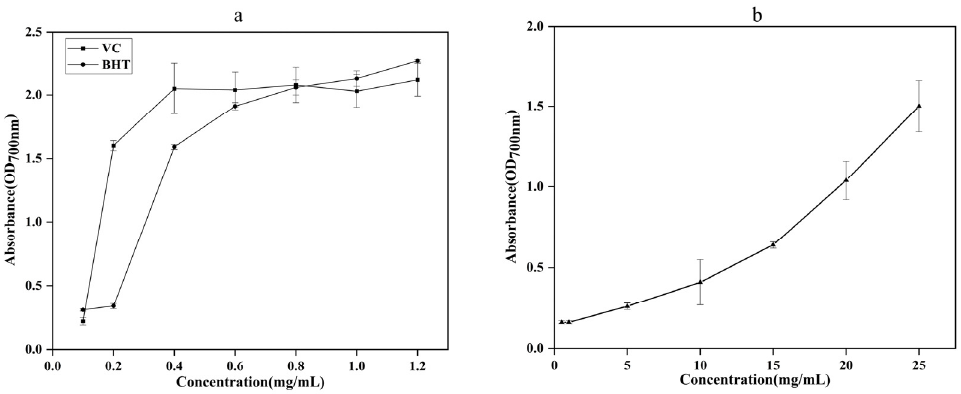
Figure 2. The total reducing capacity of VC, BHT ( a ) and AgEo ( b ).